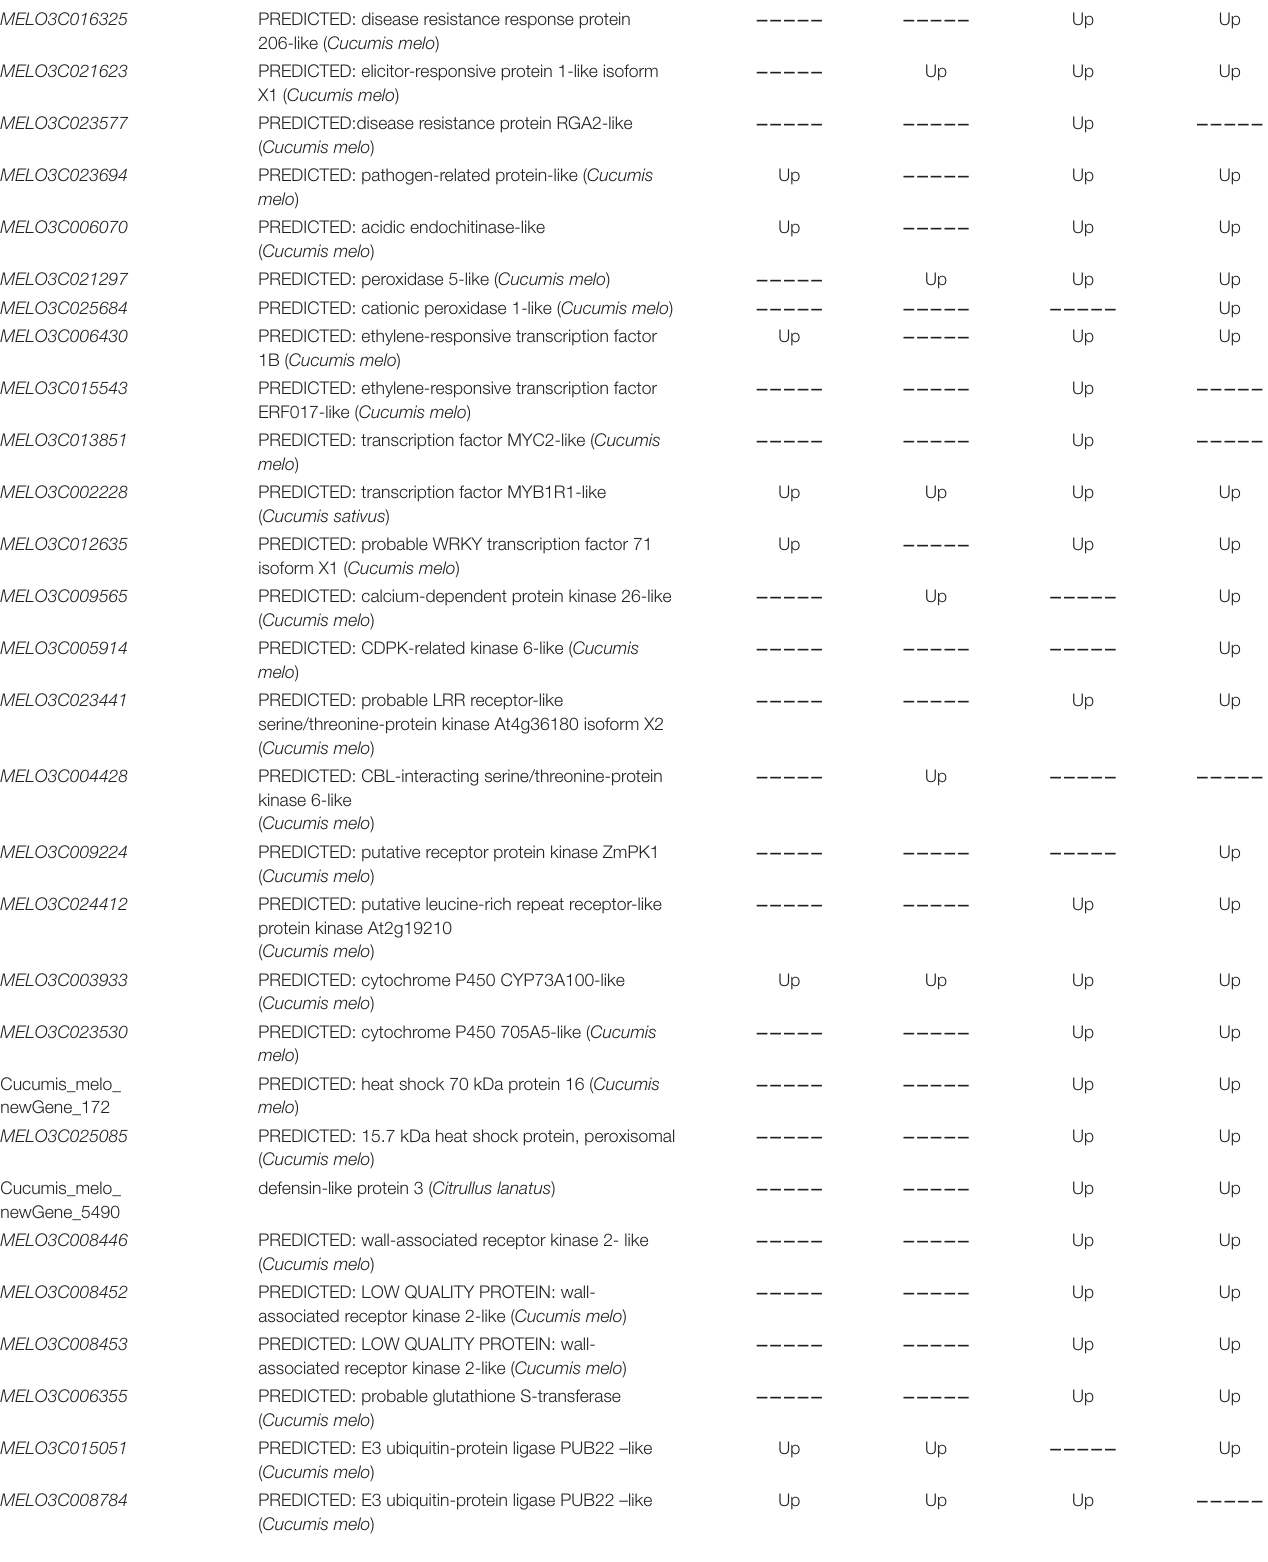
TABLE 2 | Identification of candidate DEGs with a strong correlation module using WGCNA.